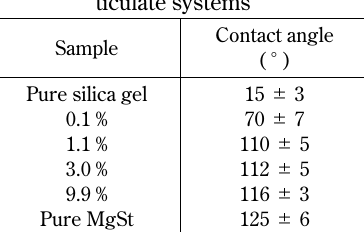
Fig. 11 Contact angle measurements ( (cid:155) ) as a function of the sample MgSt